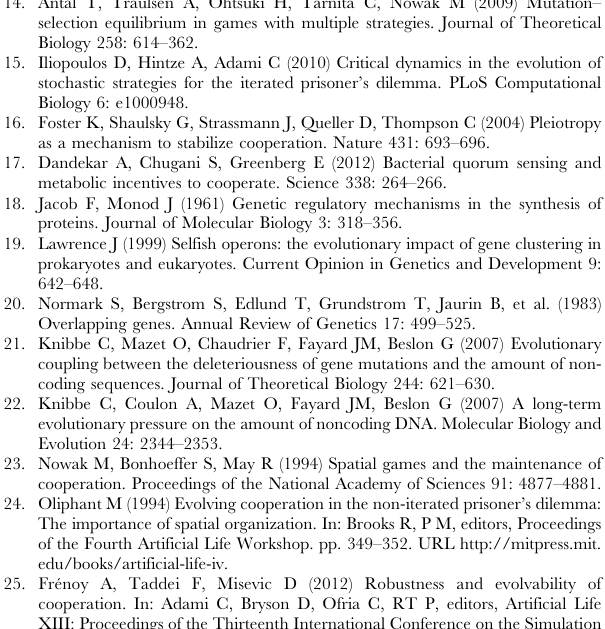
Figure S2 Groups of cooperators do better than groups of defectors. For each of the 50 populations, we plot the benefit of cooperation, i.e. the average fitness drop individuals